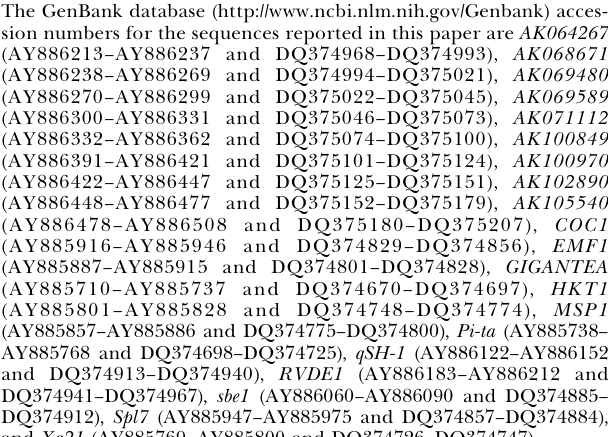
Table S2. Summary of GC Content and TE Abundance by Sliding Window Analysis of 1-Mb Window Length and 0.1-Mb Intervals across j-Npb Genome